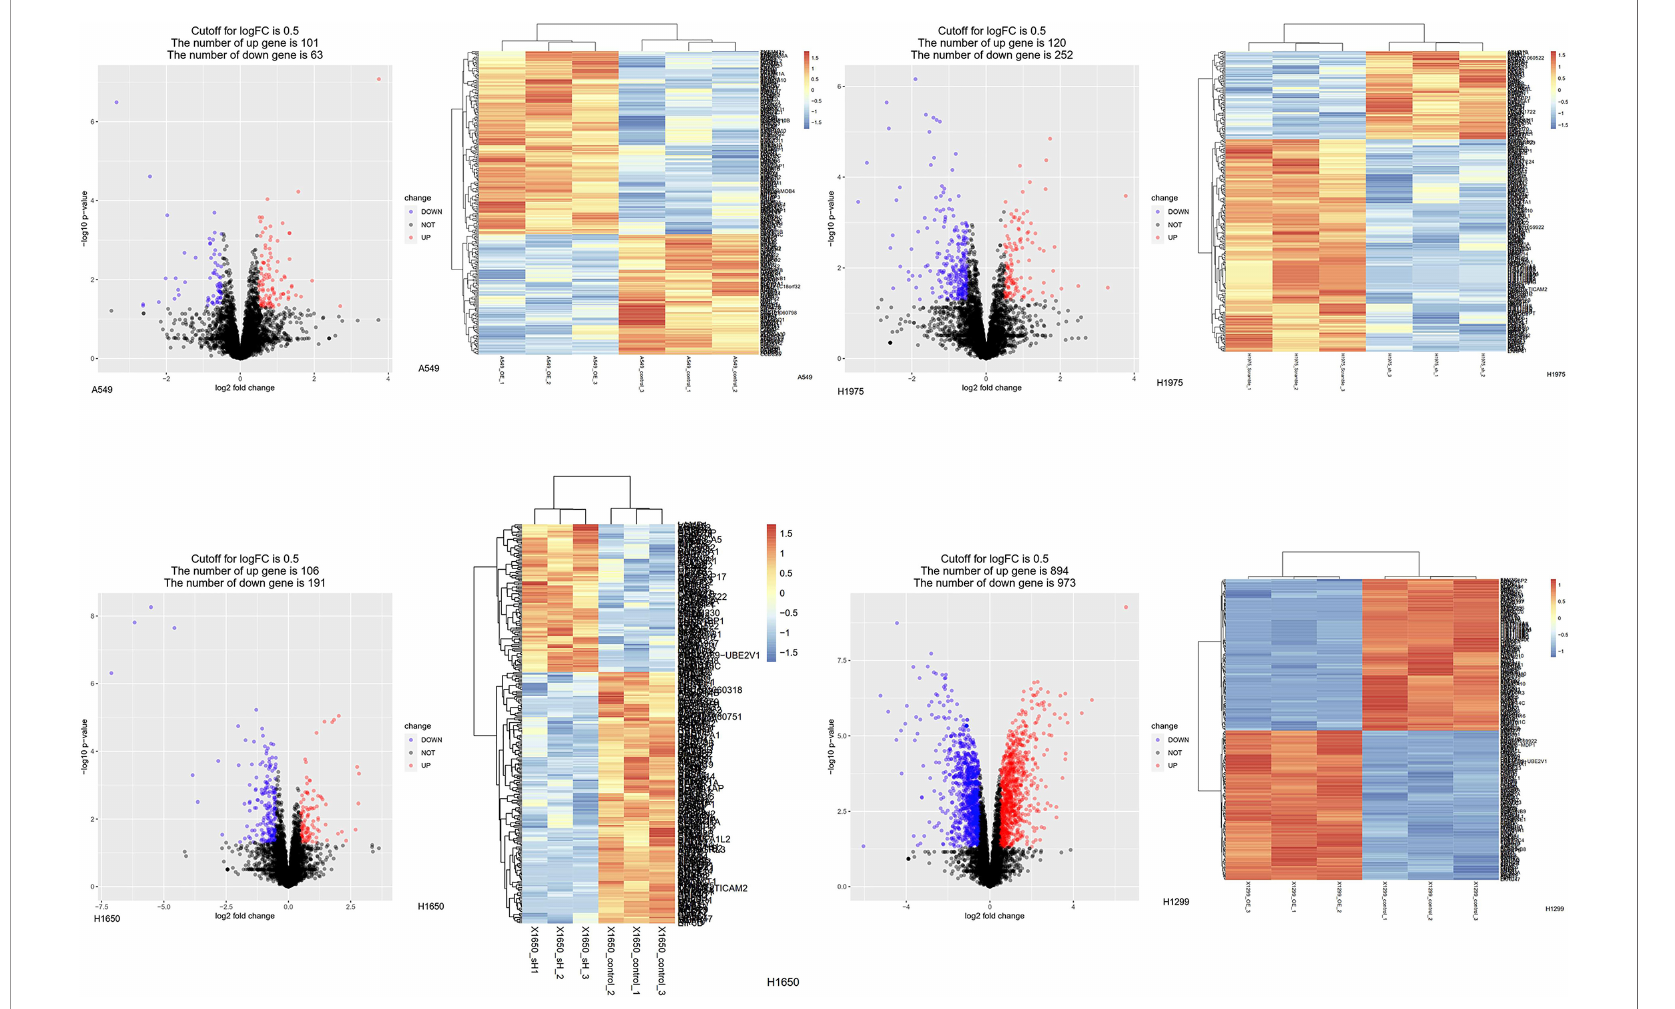
FIGURE 10 | Protein changes of LUAD cell lines induced by knockdown or overexpressed of ASF1B. Differentially expressed proteins in stable transfection cell lines compared to negative control. (Volcano plot) Red presents up-regulated proteins, blue represents down-regulated proteins, and black presents no signi fi cantly differentially expressed proteins. (Heatmap) The expression patterns of these differentially expressed proteins can distinguish between stable transfection cell lines and negative